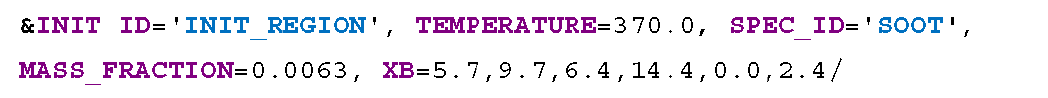
Figure 3. Example FDS input for specification of the initial region in the apartment enclosure.